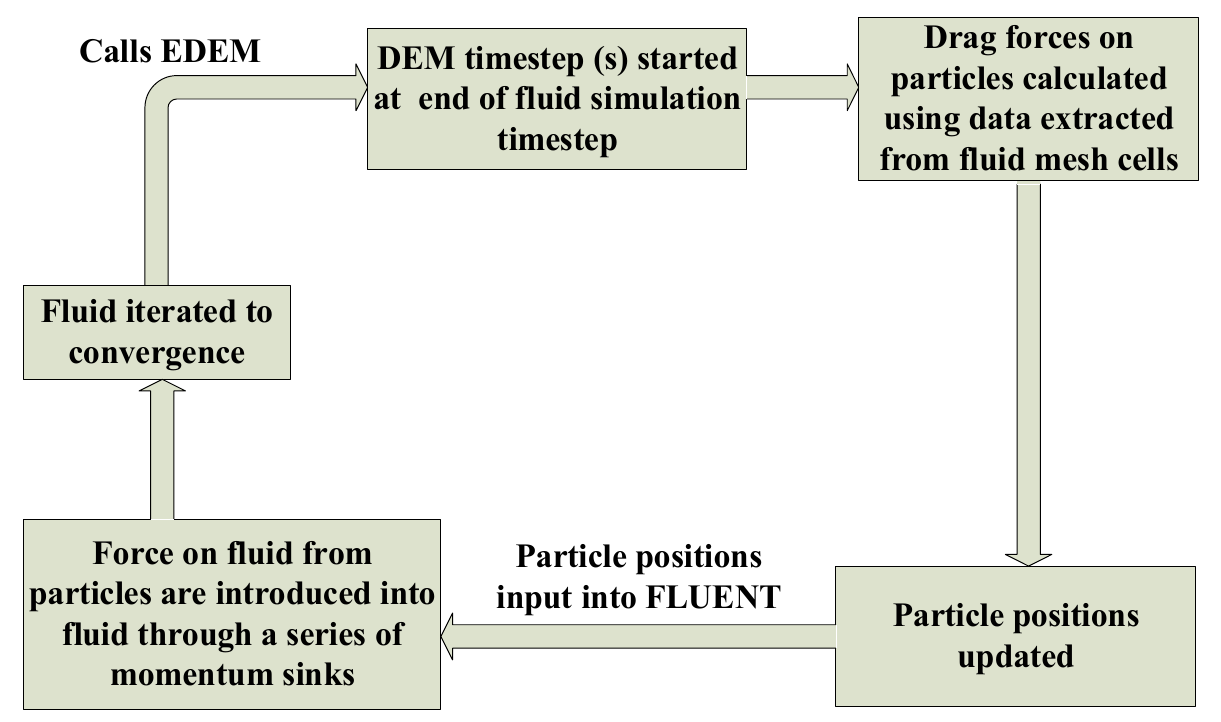
Figure 2. EDEM-FLUENT coupling process flow.